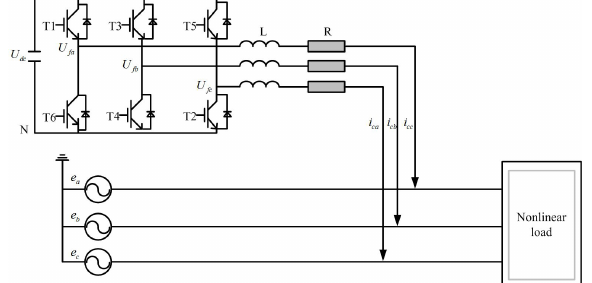
Fig. 2. Working principle of main circuit of shunt active power